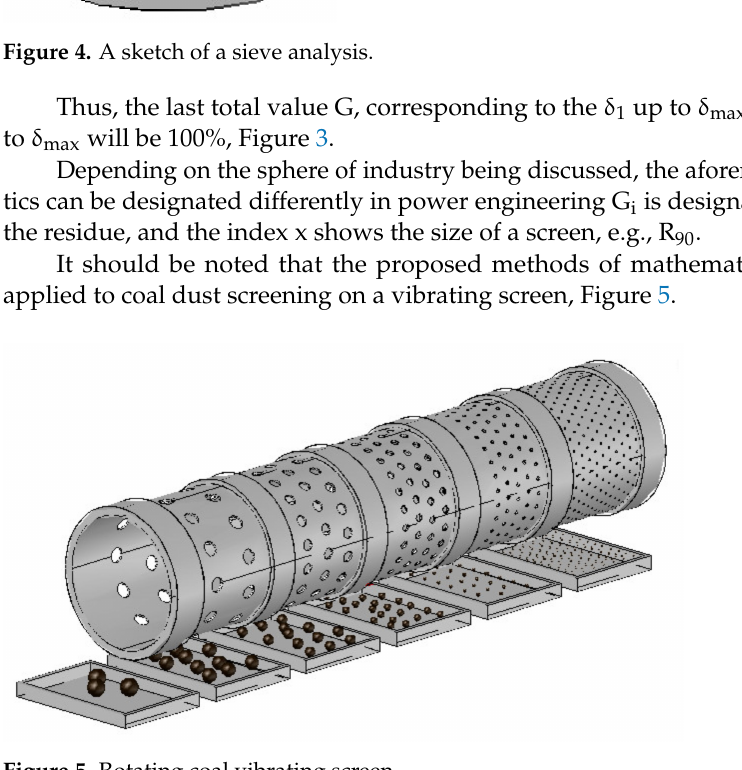
Figure 5. Rotating coal vibrating